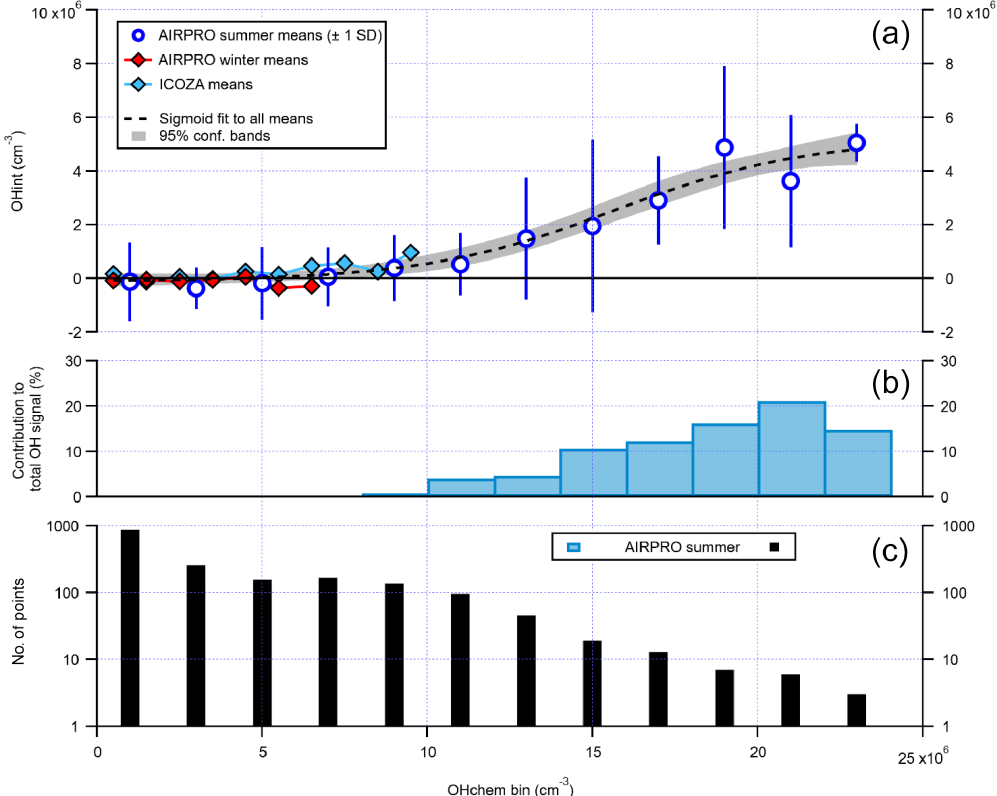
Figure 16. The relationship between OH int and OH chem using binned data. The error bars for AIRPRO summer ( a , blue markers) denote 1 SD and are not shown for AIRPRO winter and ICOZA for clarity. The dashed black line corresponds to a sigmoid fit and is used to guide the eye only. The contribution of interferences to the total OH wave signal ( = OH int / OH wave × 100%) for the AIRPRO summer campaign is shown in (b) , with the number of points in each bin shown in (c) . All OH int data used here have been corrected for the known interference from O 3 + H 2